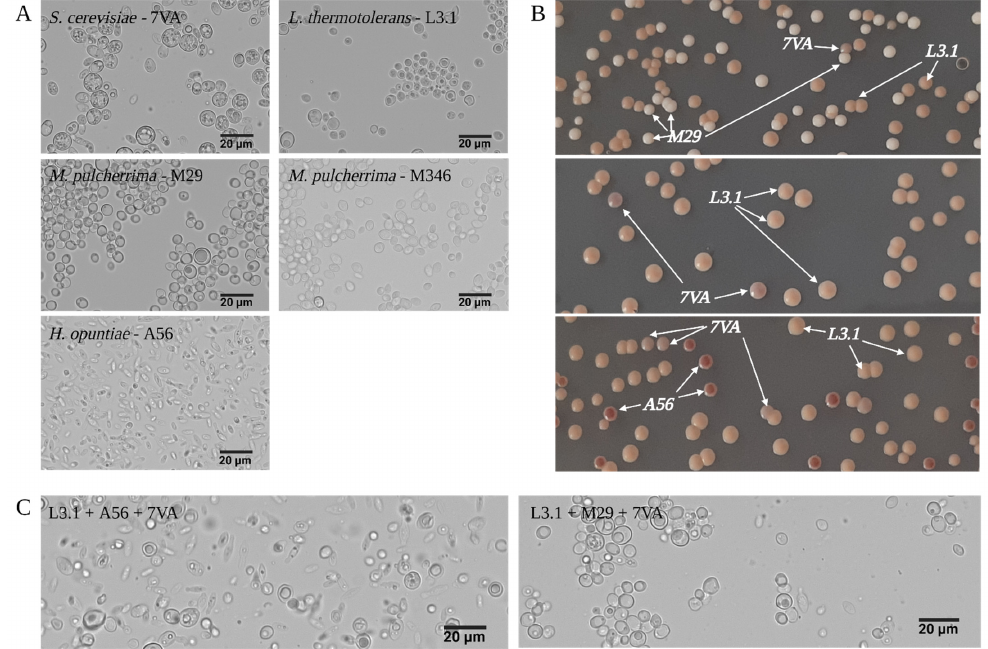
Figure 2. Optical microscopy images ( A ) of all used yeast strains. On the right ( B ), images of the colonies grown in CHROMAgar media to differentiate species by color. Samples got after the inoculation of 7VA and correspond to a sixfold dilution ( C ). In terms of oenological parameters, all wines had less than 4 g/L sugars and similar ethanol concentration (% v / v ) (See Table 1). The concentration of lactic acid was not high Table 1. Chemical composition and oenological parameters of finished wines.